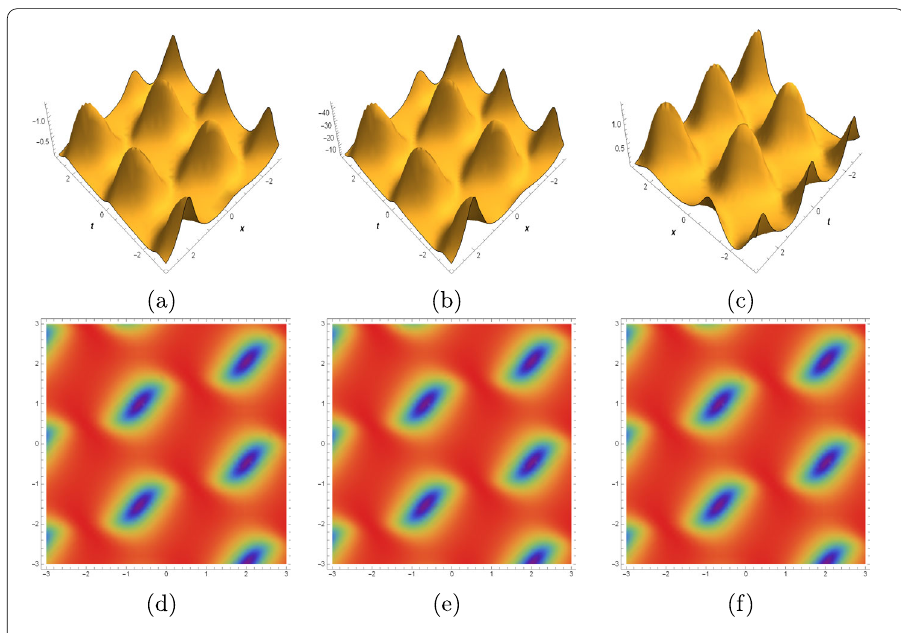
Figure 5 The 3D and density profiles of imaginary part of Eq. (14) for c 1 = 1.04, b 3 = 2.62, c 2 = 2.38